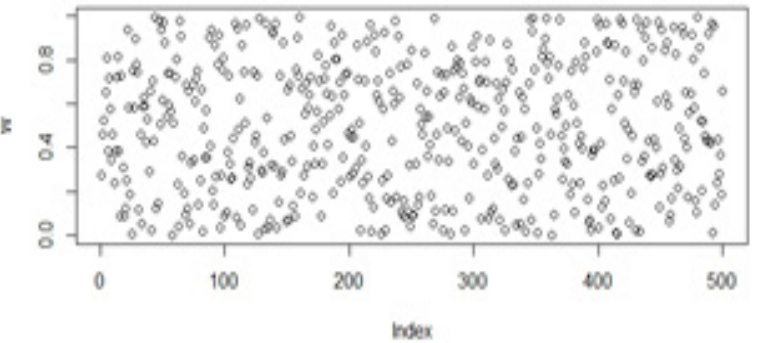
Figure 5. Population initialization using Knuth distribution.